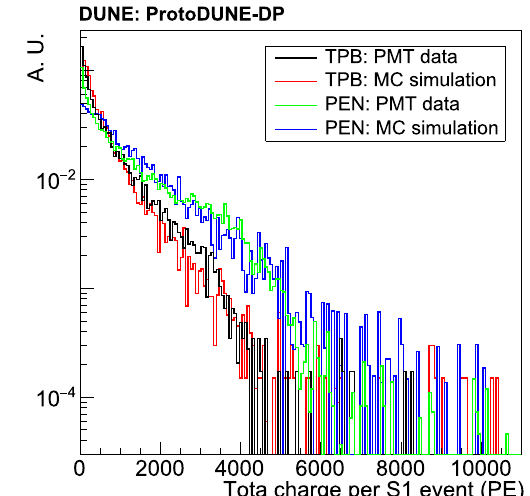
Fig. 22 Normalized distributions of the total S1 charge per cosmic muon event (sum of all detecting PMTs) in random trigger. Both data and MC (TPB and PEN) cases are displayed. The ADC saturation in data that limits the charge range is fairly reproduced in the